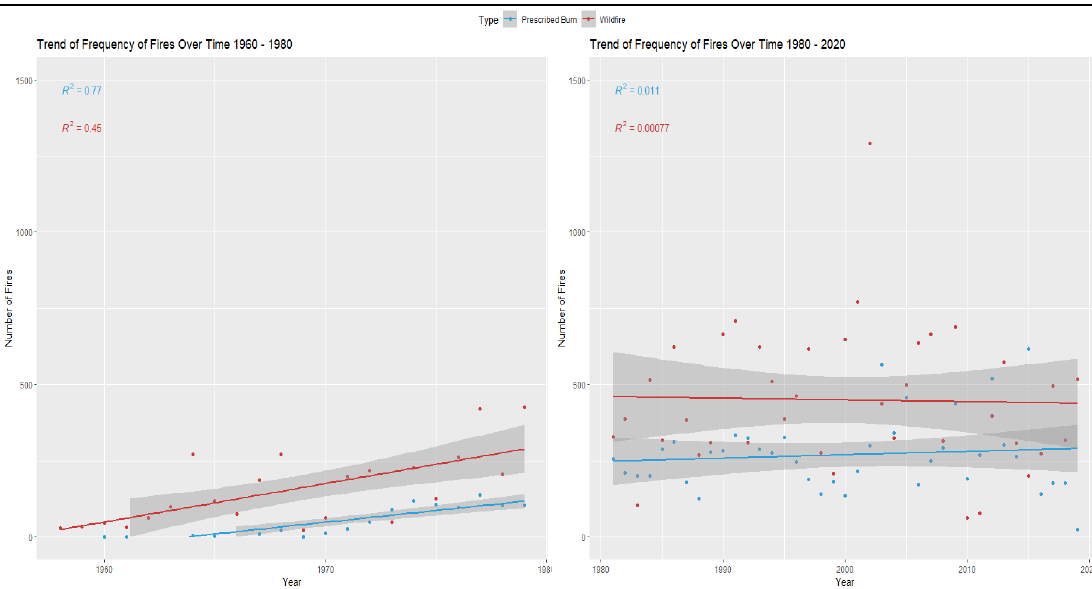
Figure 11. Increase in the frequency of fires over time, split in two bins.